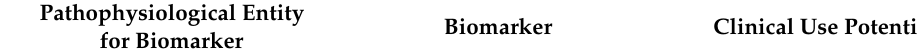
Table 2. Biomarkers for acute respiratory distress syndrome